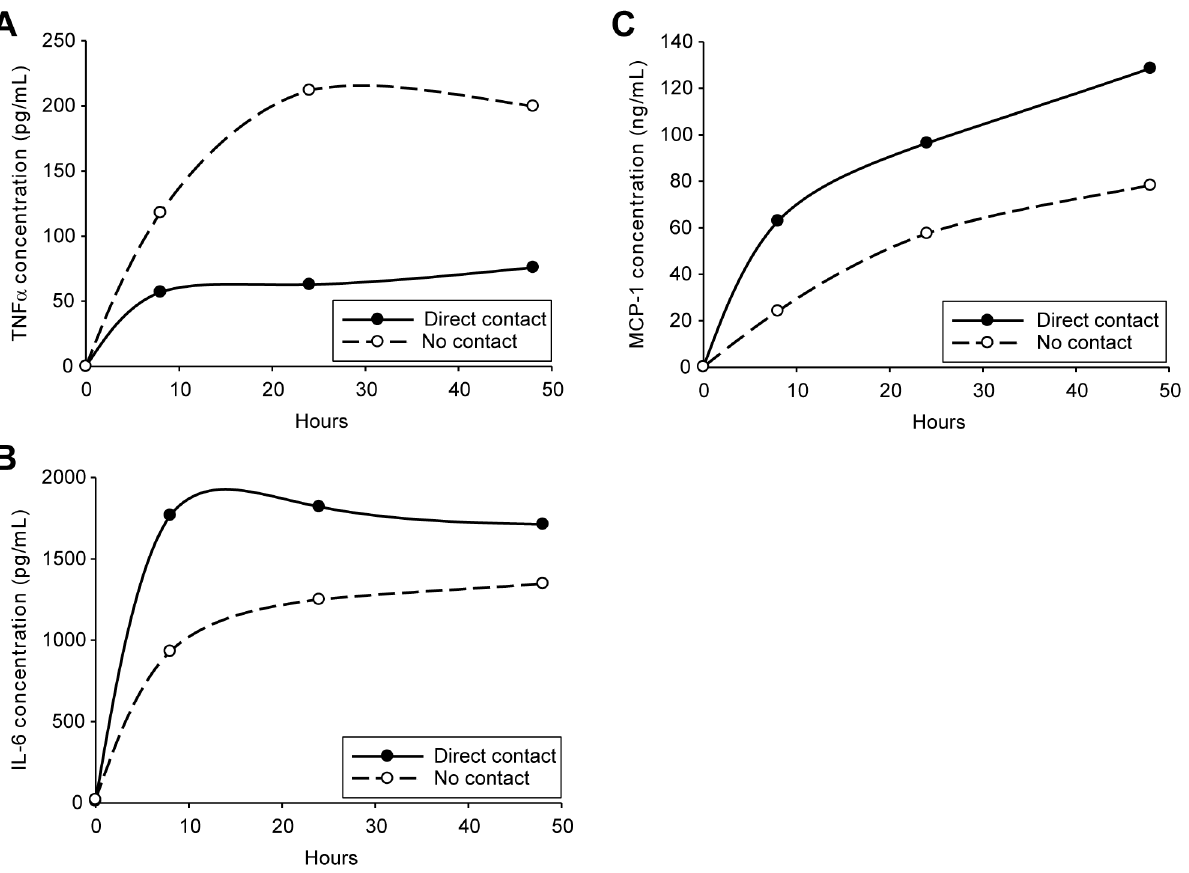
Figure 2. Rates of cytokine secretion and overall levels are affected by direct contact between adipocytes and splenocytes. Differentiated 3T3-L1 adipocytes and isolated murine splenocytes were co-cultured with no contact (separated by a 0.4 m m transwell filter system) (dashed lines) or with direct contact (solid lines) and incubated with LPS (1 m g/mL) for 0, 8, 24 and 48 h. Cytokines, TNF a (A), IL-6 (B) and MCP-1 (C), were measured in culture media following these incubation times by capture ELISA. All experimental points were performed in triplicate.